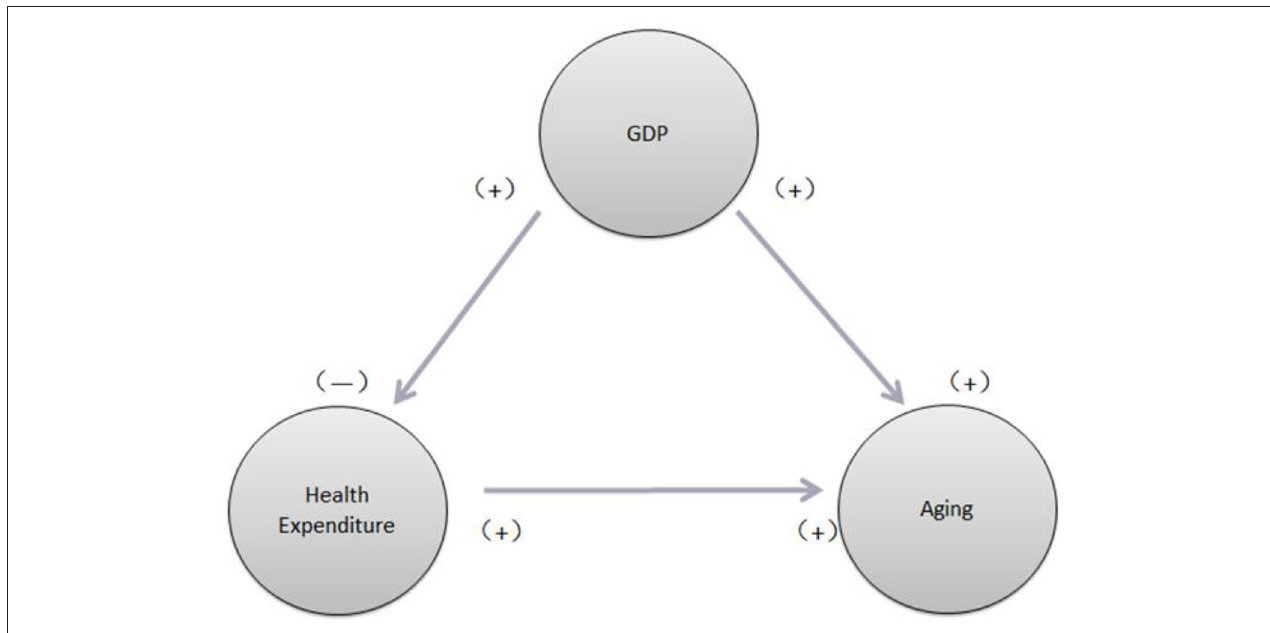
FIGURE 2 | Causal links among healthcare expenditure (HCE), aging ratio (OLDR) gross domestic product (GDP) (economic